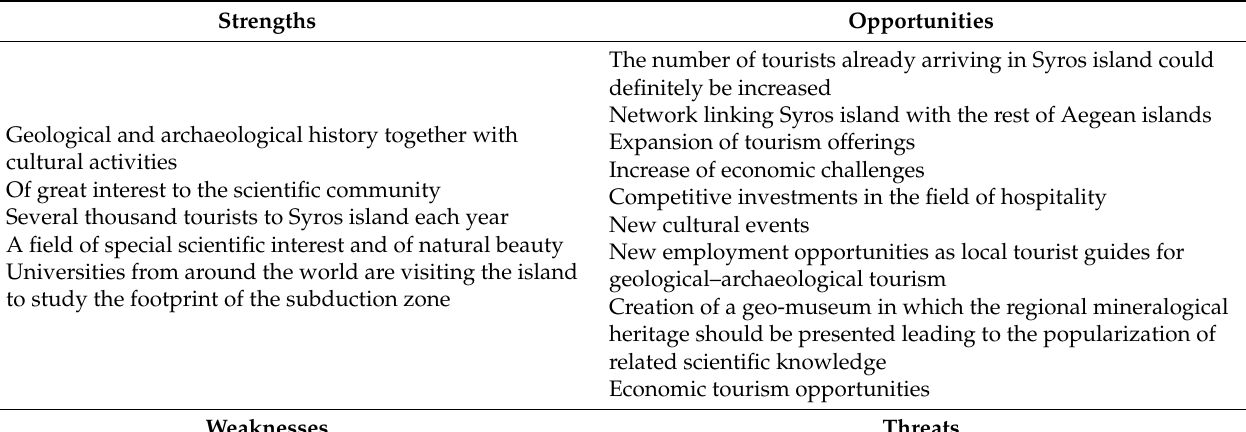
Table 3. Strengths, weaknesses, opportunities, and threats (SWOT)